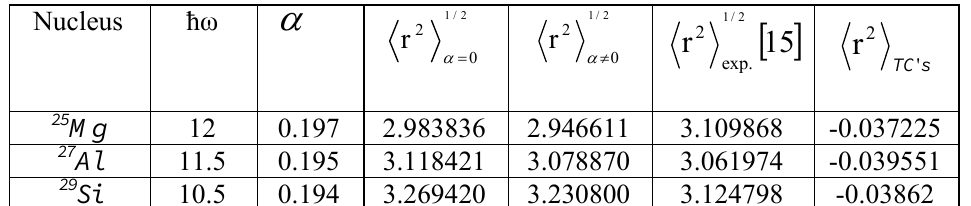
Table 1: Parameters which have been used in the calculations of the present work for the 2BCDD's, 2/1 and elastic longitudinal F(q)'s of all nuclei under study. 2 r